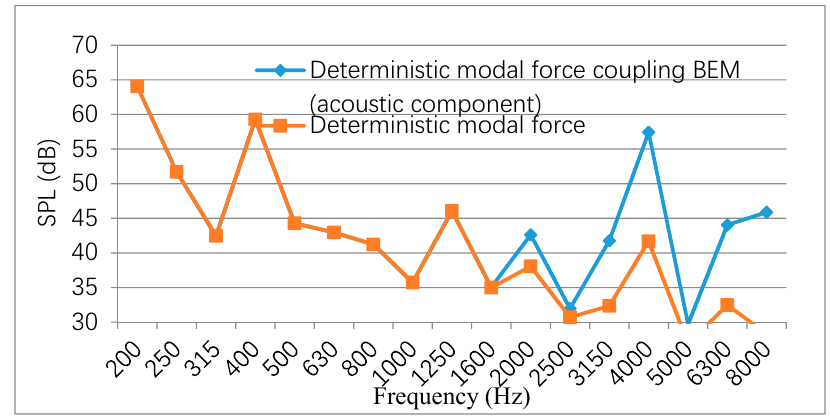
Figure 21. Radiated SPLs of the panel under the deterministic modal force with and without acoustic component.